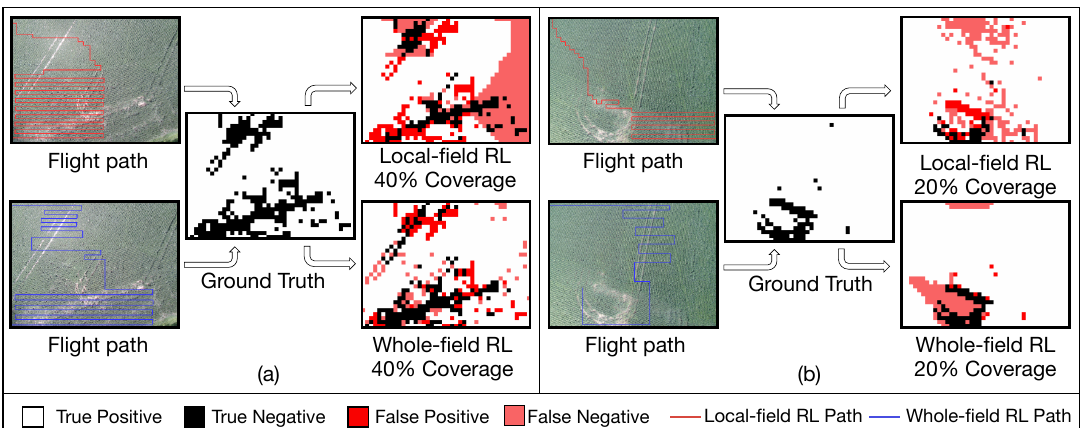
Figure 6. Different crop health maps and flight paths generated by whole-field and local-field RL at 20% and 40% coverage.